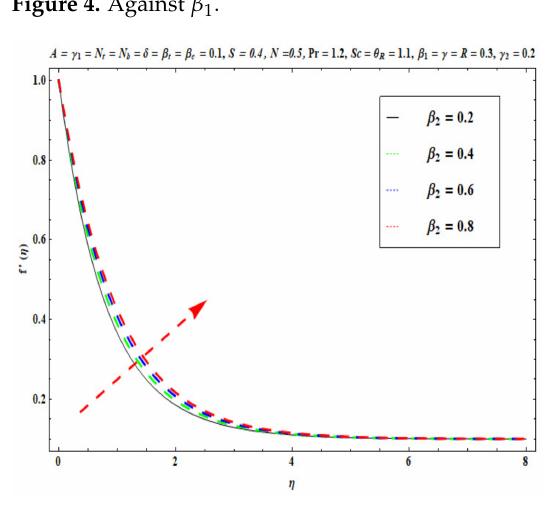
Figure 5. Against β 2 .